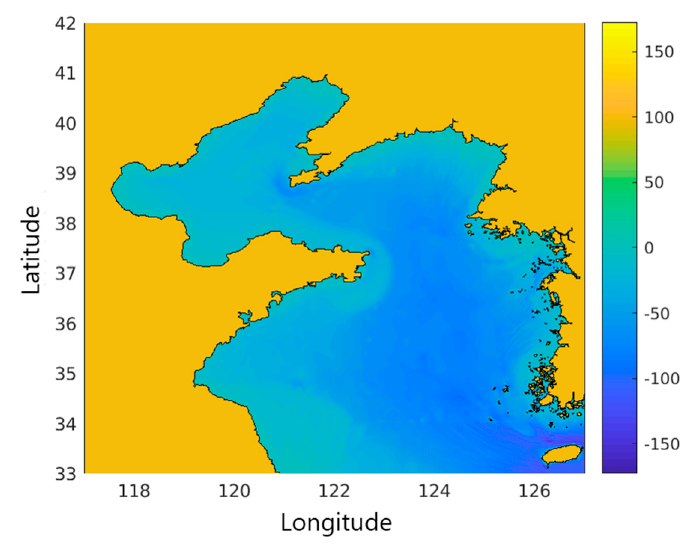
Figure 1. Bathymetry of the Yellow Sea and numerical domain.